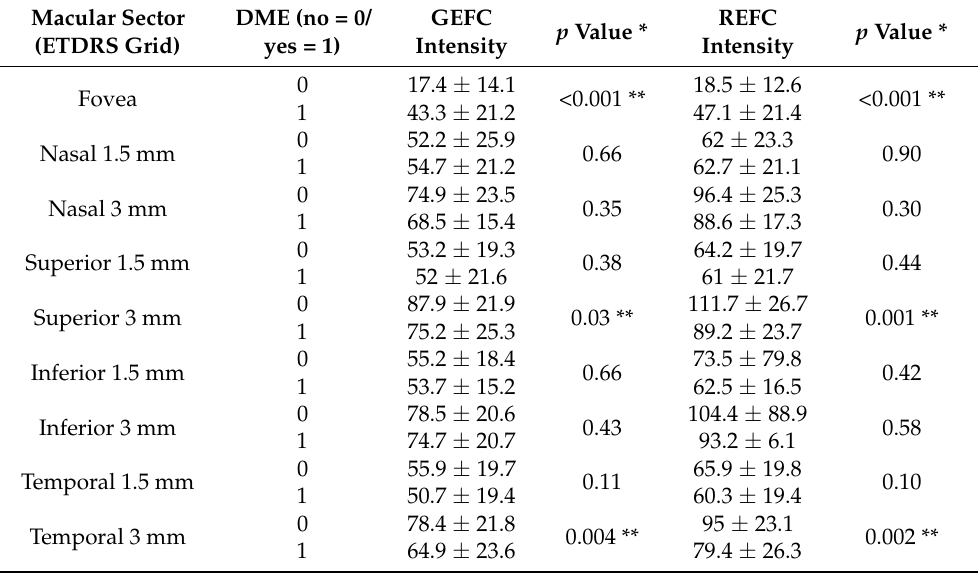
Table 2. Comparison between GEFC and REFC intensity values in eyes with and without diabetic macular